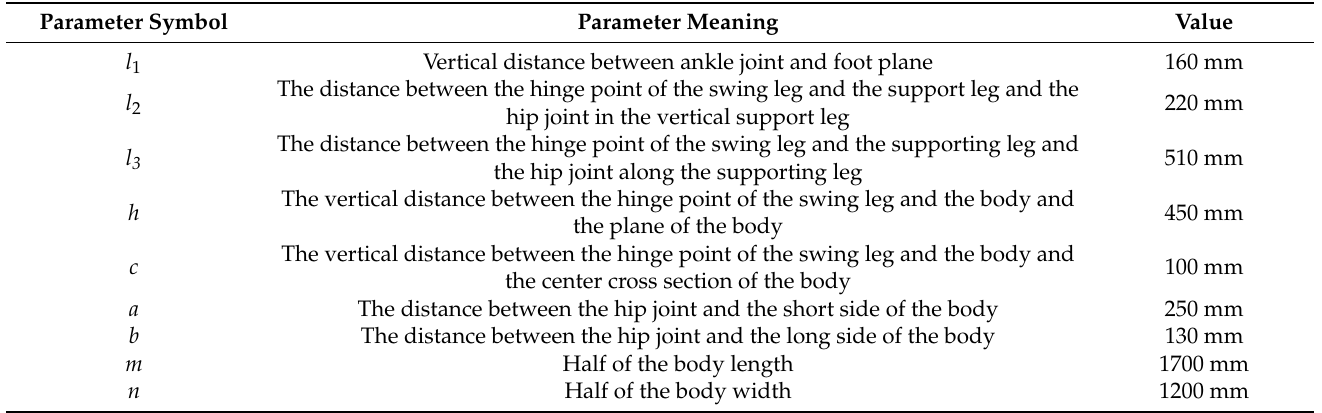
Table 1. Kinematics model parameters of dredging